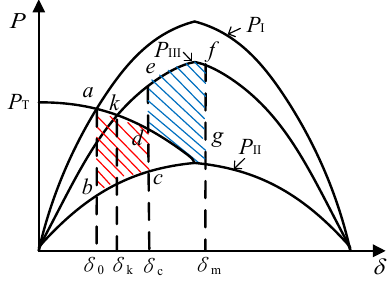
Figure 6. Power angle curve.